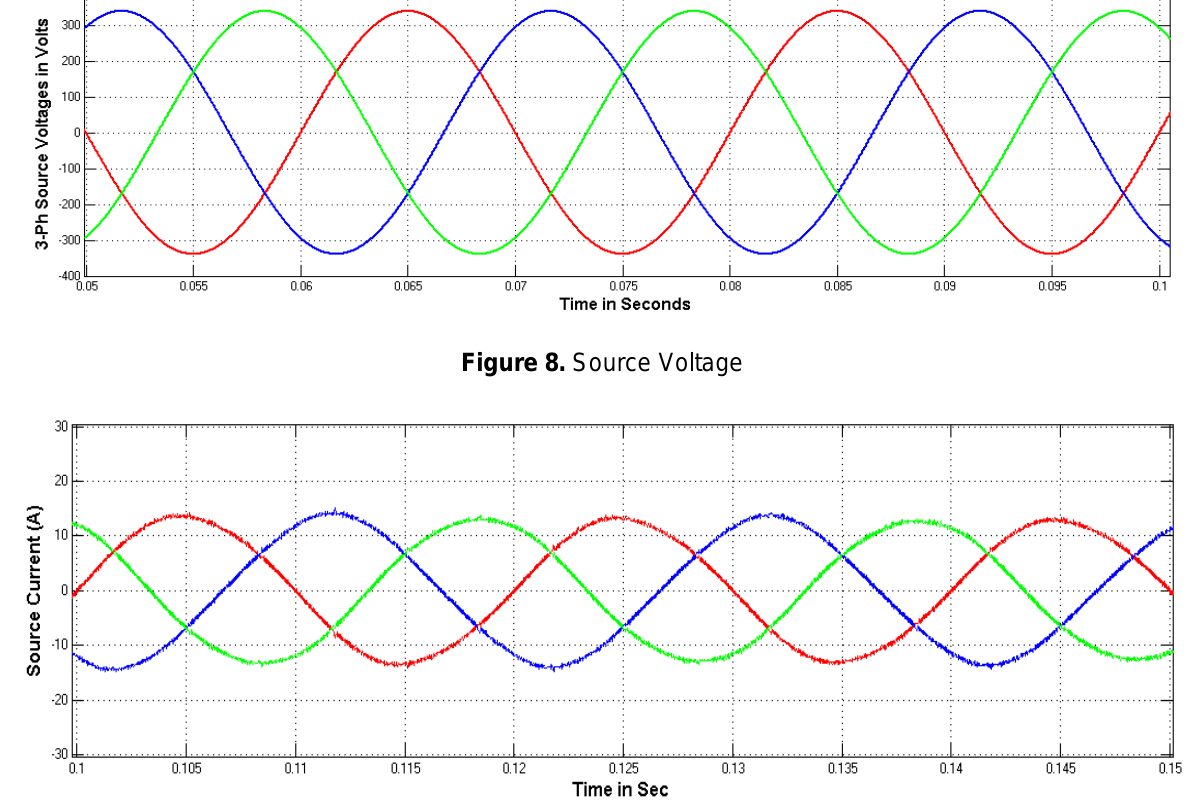
Figure 9. Three-phase source Currents